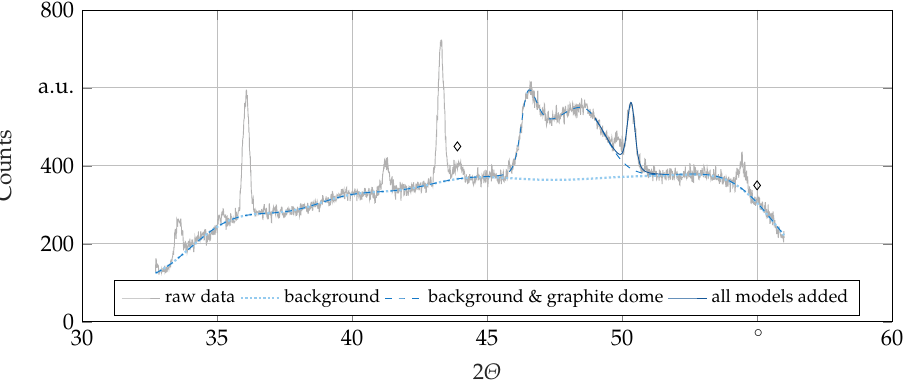
Figure 3. Diffractogram of the last frame of the in-situ dataset from sample 4 at T TH4 with graphs of the various models fitted to the raw data. Diamond markers: Possible peaks of a high temperature phase not present in ambient